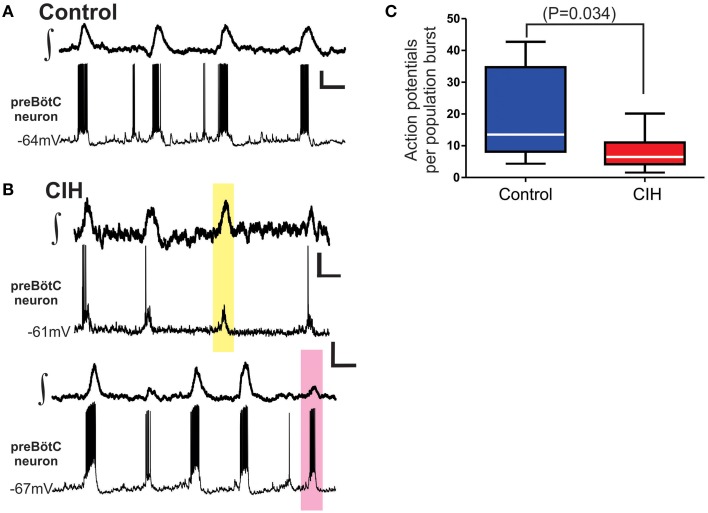
CIH alters neuronal excitability coupled to the network rhythm. (A) Representative traces paired recordings of the integrated preBötC network rhythm (∫,top) and membrane potential (Vm) of an individual preBötC neuron participating with the network (bottom) from a control slice. (B) Representative traces of paired recordings from two individuals slices illustrating the change in firing pattern during network activity and fidelity of individual preBötC neurons relative to the network rhythm following CIH. The yellow box highlights the lack of action potential generation from the preBötC neuron during network burst (top pair). The pink box highlights robust action potential generation from a preBötC neuron occurring during a smaller subnetwork network burst (bottom pair). Vertical Scale Bars: 10 mV; Horizontal Scale Bars: 500 ms. (C) Summarized data shows that, in aggregate, number of action potentials generated by individual preBötC neurons during the network burst is reduced following CIH.